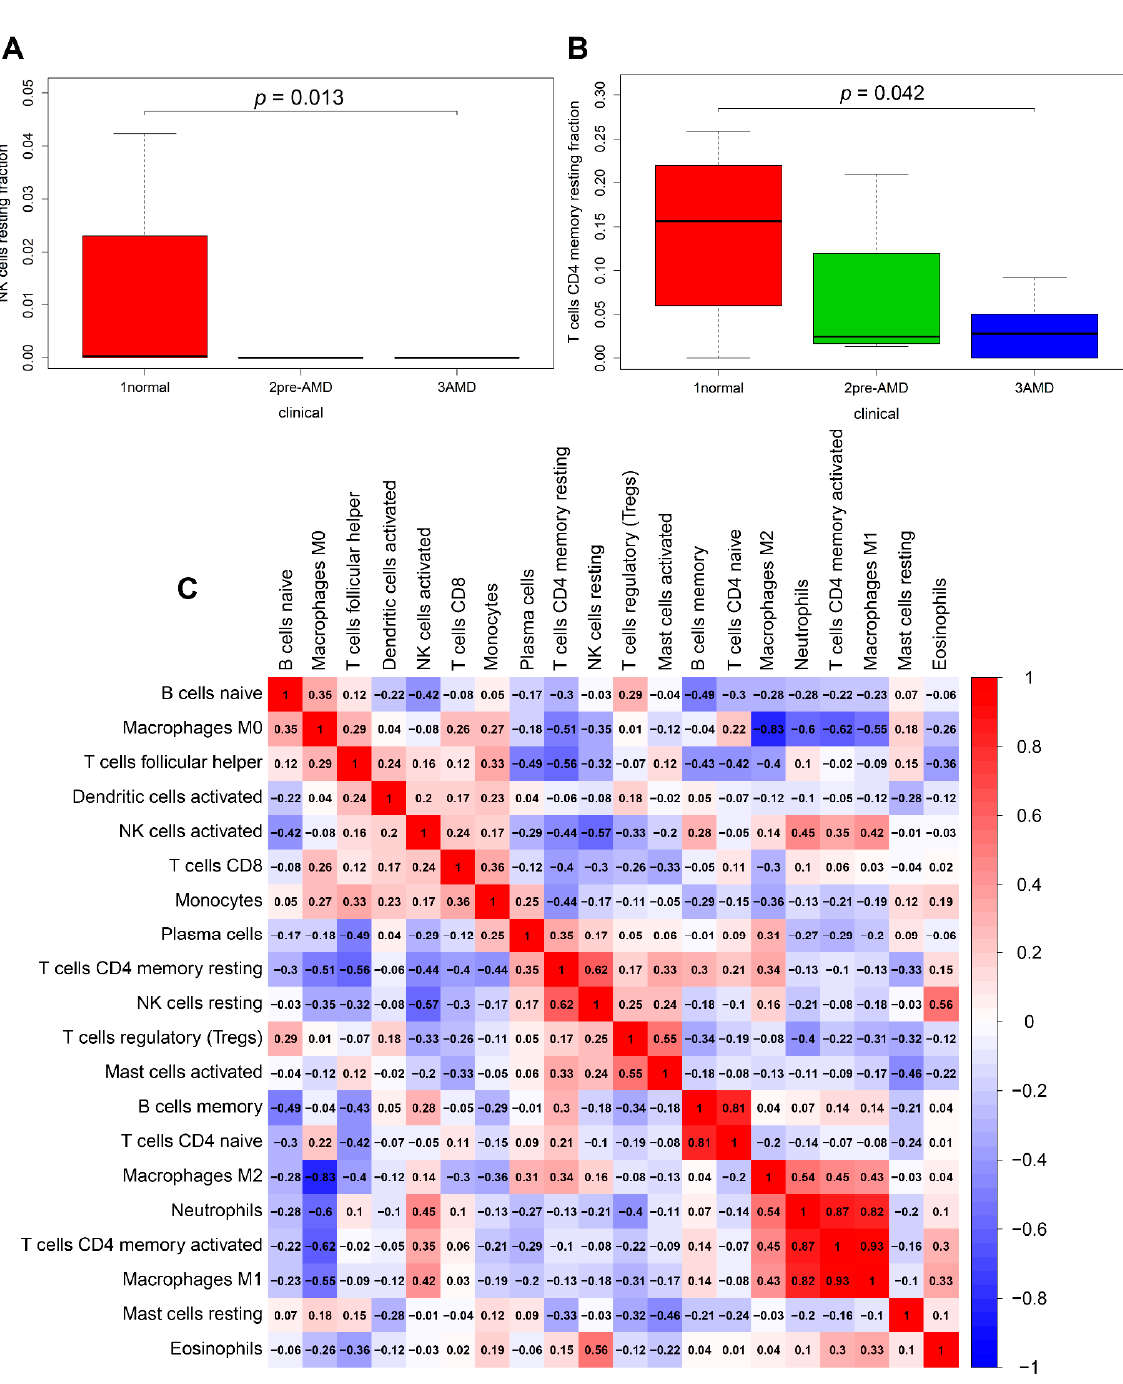
Figure 7. Clinical relevance and correlation analysis of the infiltrating immune cells. The association between the progress of AMD with the resting NK cells ( A ) and resting CD4 memory T cells ( B ). ( C ) Correlation analysis between immune cell types; red indicates positive correlation and blue indicates negative correlation.